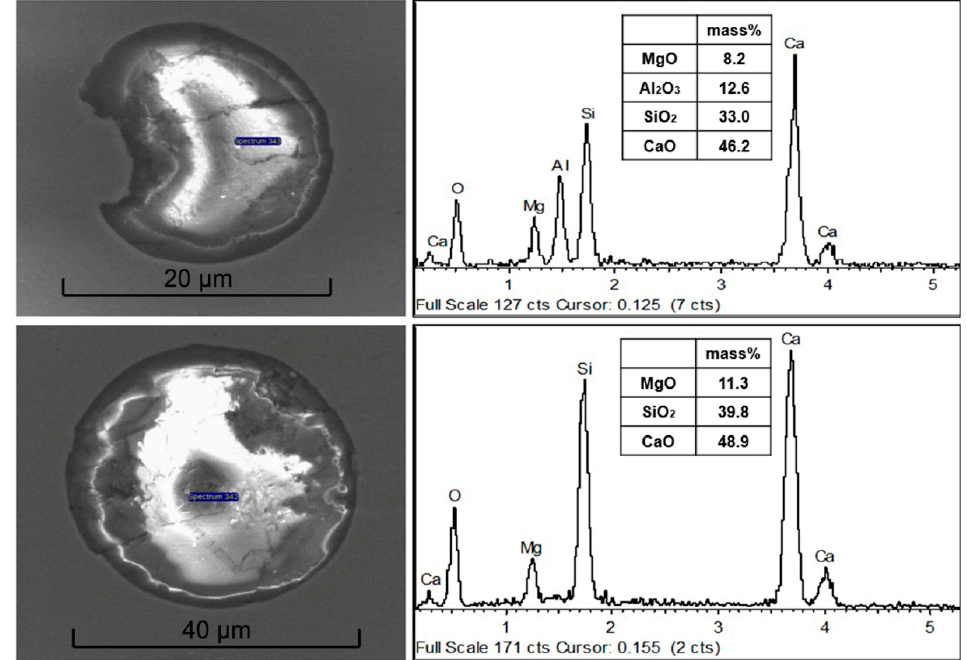
Figure 4. SEM images and EDS results of inclusions in the samples taken at AOD tapping when using low-Al FeSi alloy.